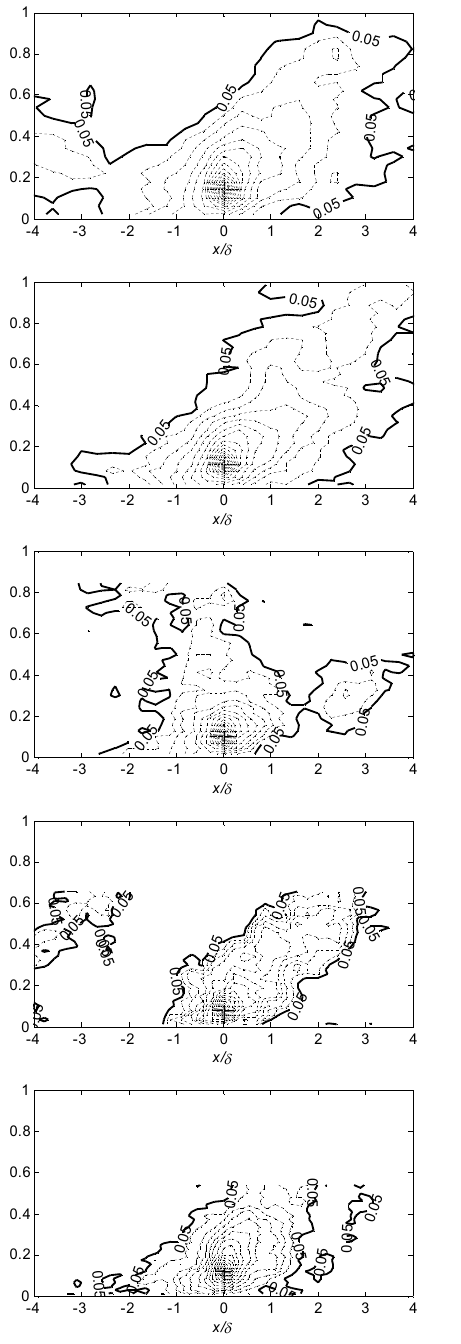
0.65 Lx   between / 0.1 z   uu